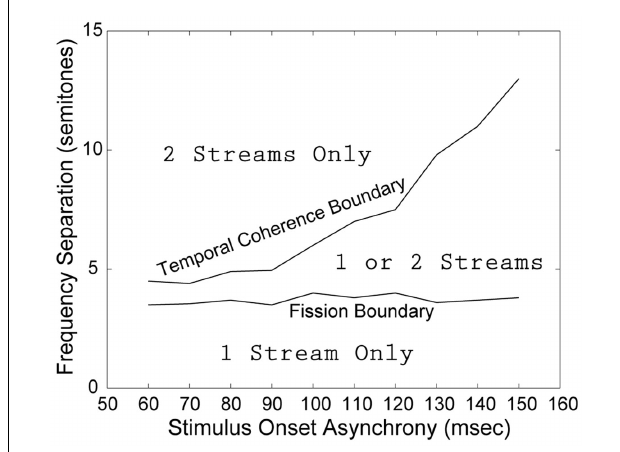
FIGURE 4 |A reproduction of Van Noorden’s (1975) streaming diagram, showing the combinations of frequency separation and stimulus onset asynchrony between low and high tones that lead to perception of only one stream, only two streams, or either perceptual organization.